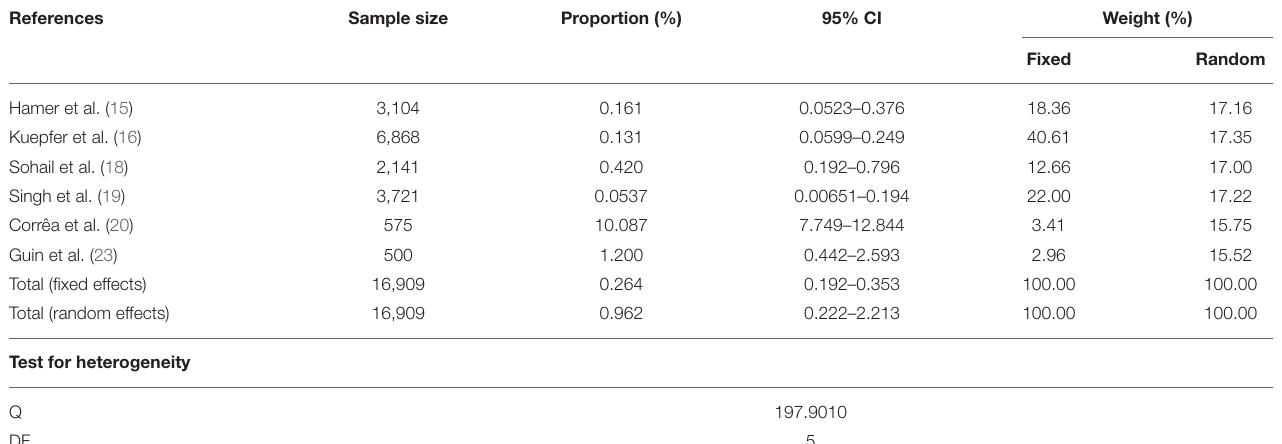
TABLE 10 | Pooled prevalence of mixed infection in pregnant